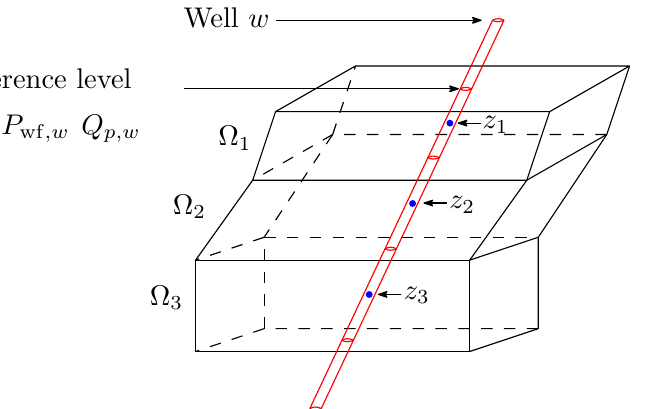
Figure 2. Schematization of the geometric elements involved in the discretization of well